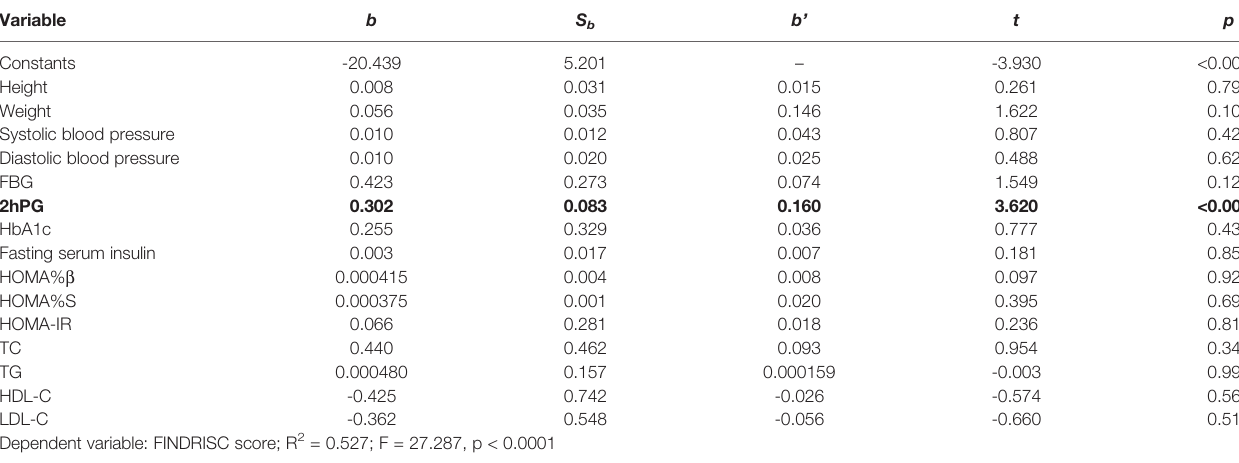
TABLE 5 | Multivariable linear regression of FINDRISC .